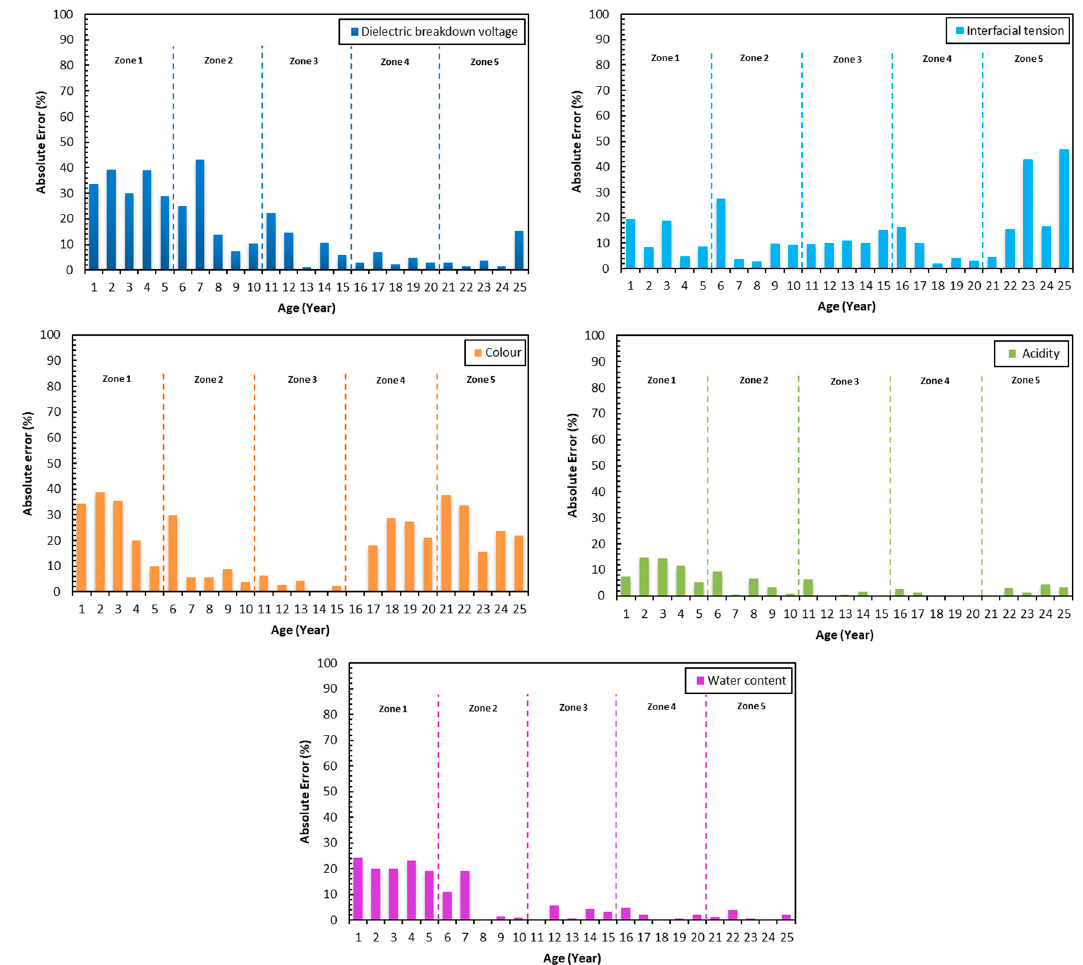
Figure 8. Percentage of absolute error between computed and predicted dielectric breakdown voltage, interfacial tension, colour, acidity and water content.